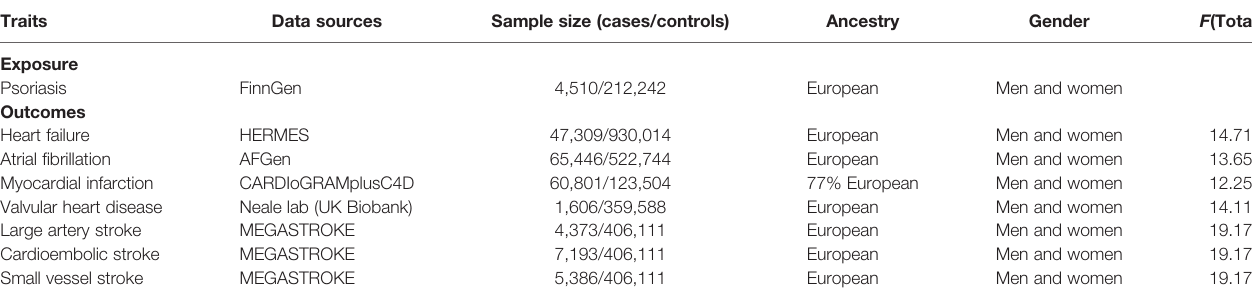
TABLE 1 | Data sources and instrumental variable strength